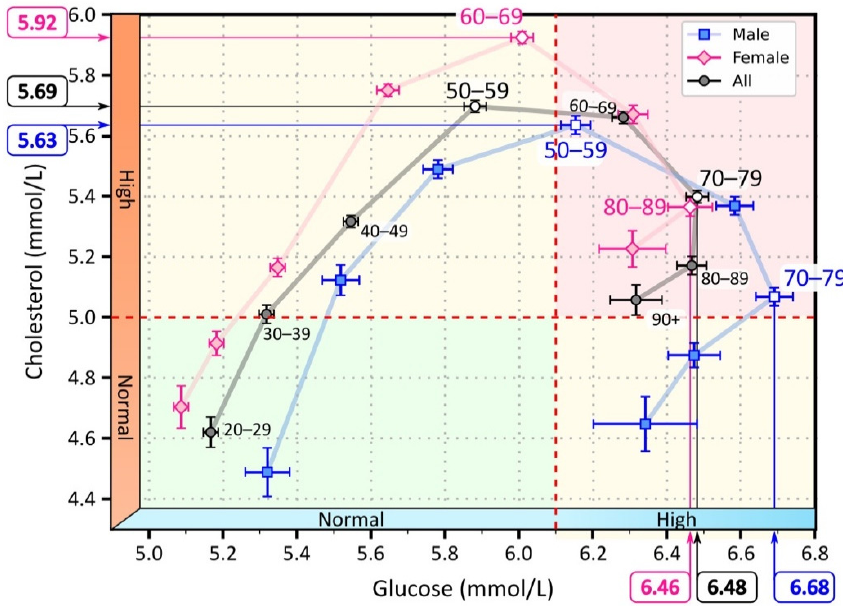
Figure 2. Mean values of serum cholesterol and glucose for different age groups. The light pink diamonds represent measurements for female patients, the light blue squares for male patients, and the black circles represent the overall mean for male and female patients. The white-filled symbols indicate extreme values: the maximum cholesterol values in the age groups 50–59 (men), 60–69 (women), and 50–59 (all), and the maximum glucose values in the age groups 70–79 (men), 80–89 (women), 80–89 (all). The background colors in the figure highlight the area with normal cholesterol and glucose levels (green), the area with elevated cholesterol or glucose levels (yellow), and the area with elevated glucose and cholesterol levels (red).